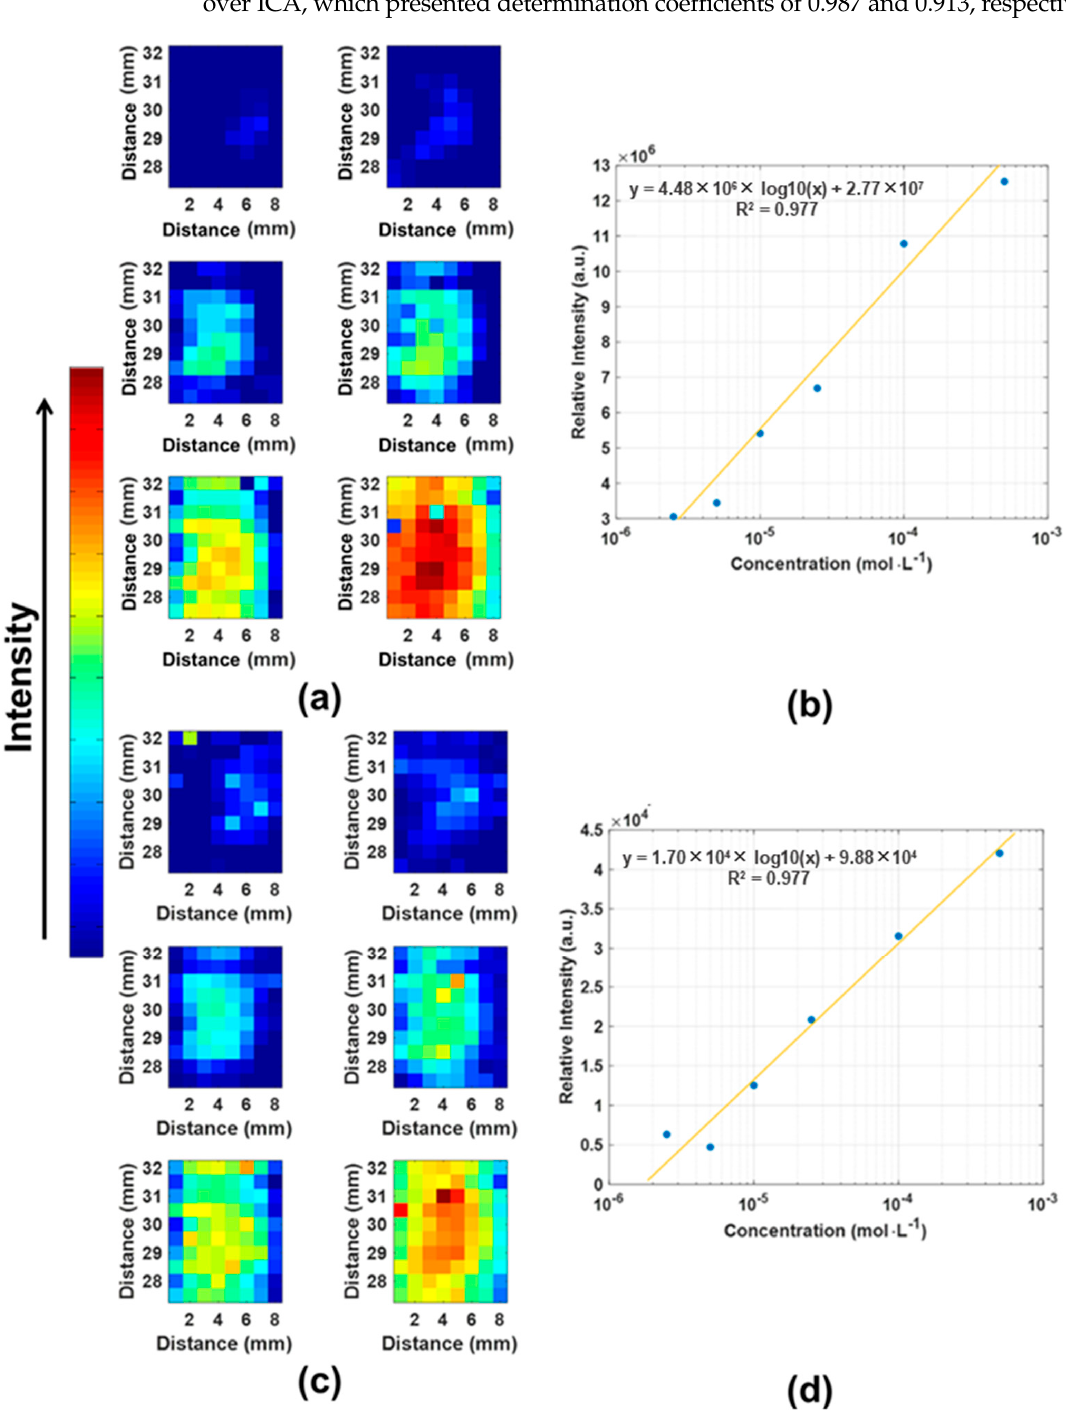
Figure 7. ( a ) SMX score maps recovered by MCR-ALS and ( b ) analytical curve. ( c ) Score maps recovered by ICA and ( d ) analytical curve.